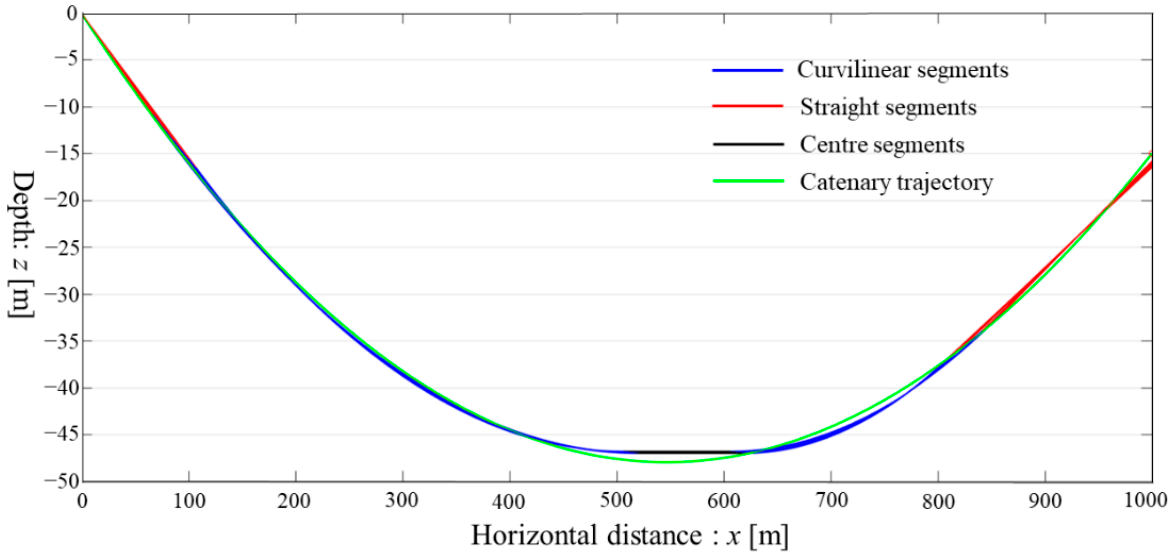
Figure 9. Trajectories after searching 20 times by IRMO: Series 4 in Table 2. The calculations completed by the IRMO showed great stability and accuracy, with the standard deviation of the SOS being 3.61244, consistent with the trajectory images. In Figure 9, different colors are used to distinguish each segment of the five-segment